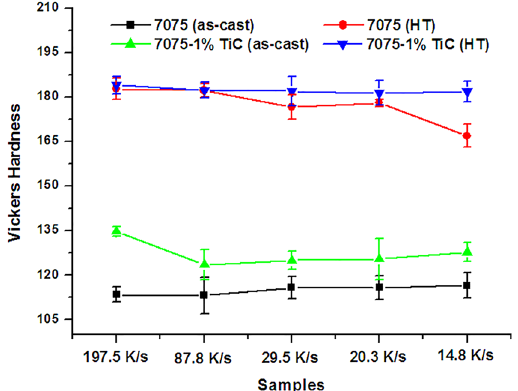
Figure 5. Variations in Vickers Hardness of AA7075 alloys with different cooling